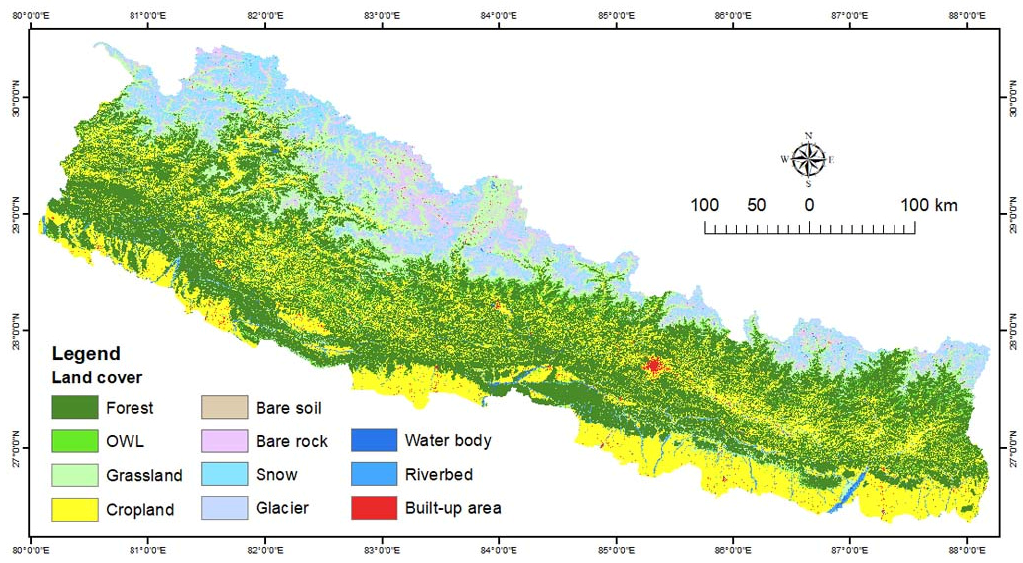
Figure 5. The landscapes indicate more risk to communities from fire events of carbon forestry (Source: DLUS 2022). Table 1. Comparative resource access position of Nepalese people relative to neighboring countries and some developed countries [Source: